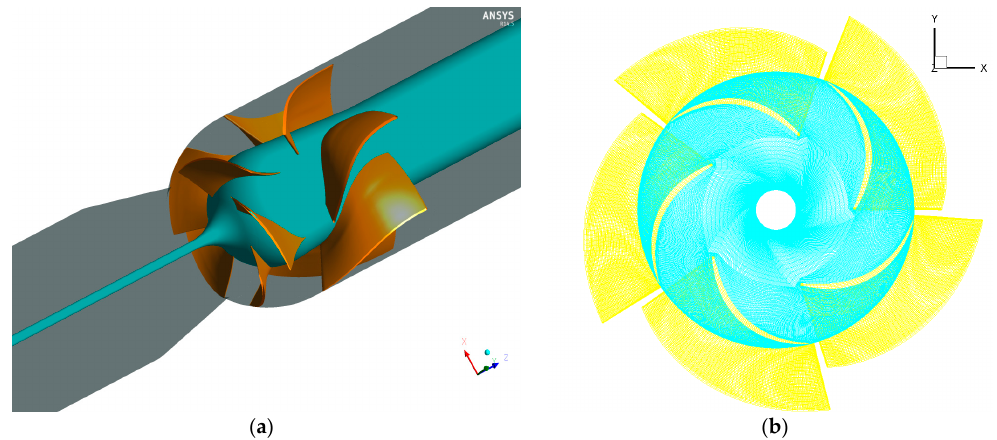
Figure 3. Computational domain of the mixed-flow pump: ( a ) Computational domain and ( b ) Impeller mesh.